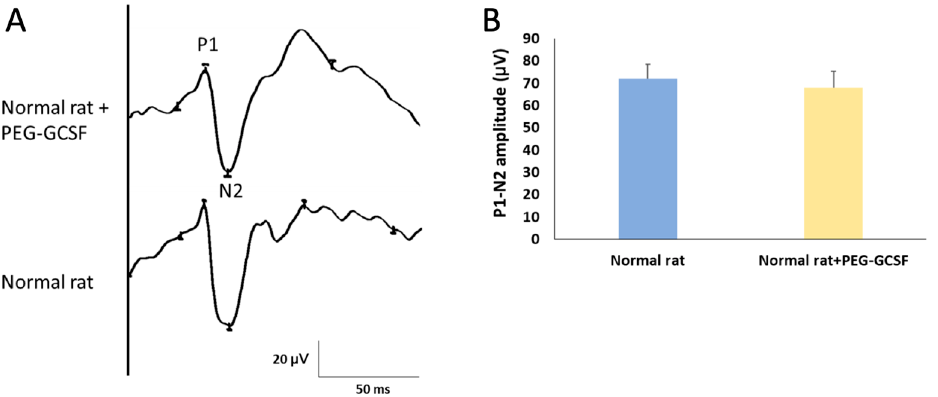
Figure 2. Evaluation of the visual function by using flash visual evoked potentials (fVEPs) in normal rats with or without intravitreal injection (IVI) of pegylated granulocyte colony-stimulating factor (PEG-G-CSF). ( A ) Representative fVEP tracings in the rats treated with or without IVI of PEG-GCSF 14 days later. ( B ) Bar charts demonstrate the P1-N2 amplitude. The values of amplitude are expressed as mean ± standard deviation (SD) in each group (n = 6 in each group). There was no significant difference in the amplitudes of the P1-N2 waves between the rats treated and not treated with IVI of PEG-G-CSF. P1, the first positive peak; N2, the second negative